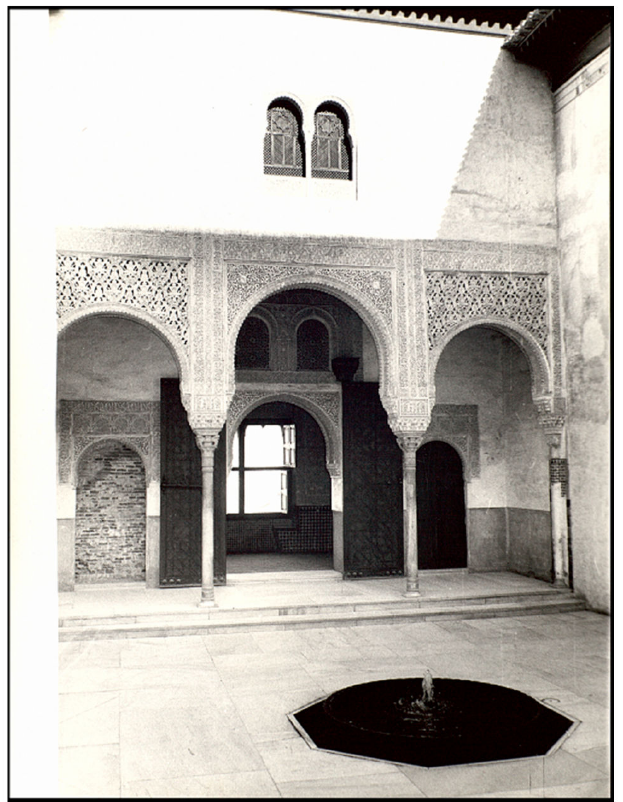
Figure 31. Cuarto Dorado portico showing remains of the alicatado work that covered the top of the engaged column shaft in the eastern edge in December 1966. © Archivo del Patronato de la Alhambra y Generalife, Photograph Collection,